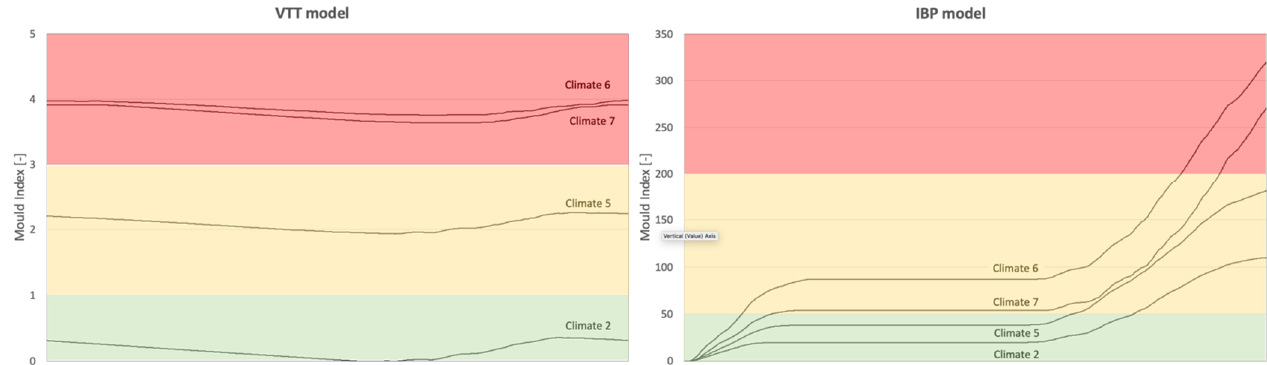
Figure 4. Mould Index value of the reference scenario in different climates assessed with VTT and IPB model. The yellow and red lines indicate the index. Only the results for the most critical interface are shown (most critical interface: external surface of the insulation in contact with the OSB).